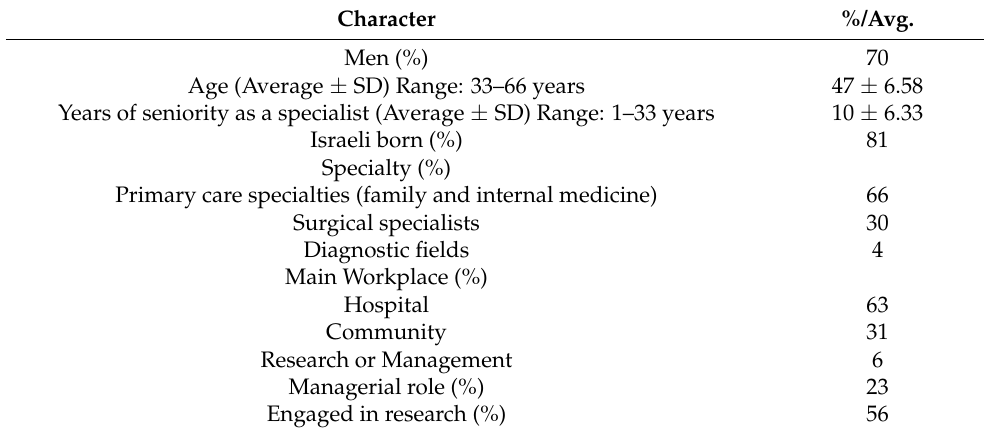
Table 1. Physicians’ Characteristics.